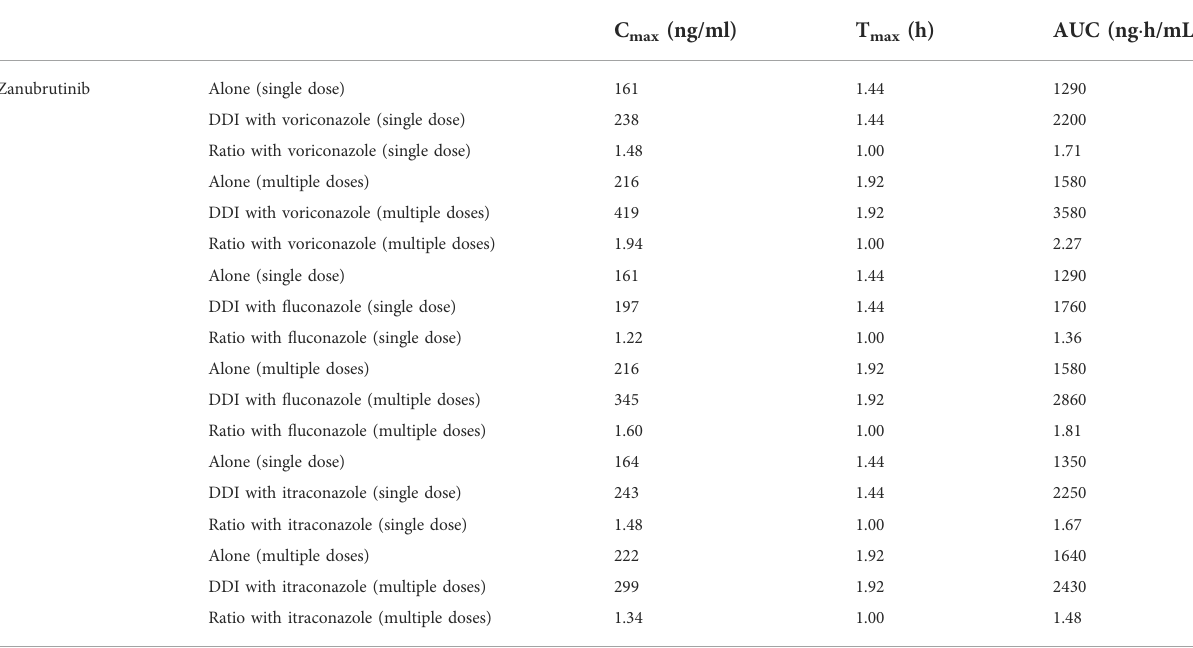
TABLE 3 Model-predicted PK parameters and ratios of zanubrutinib given alone and with triazoles.